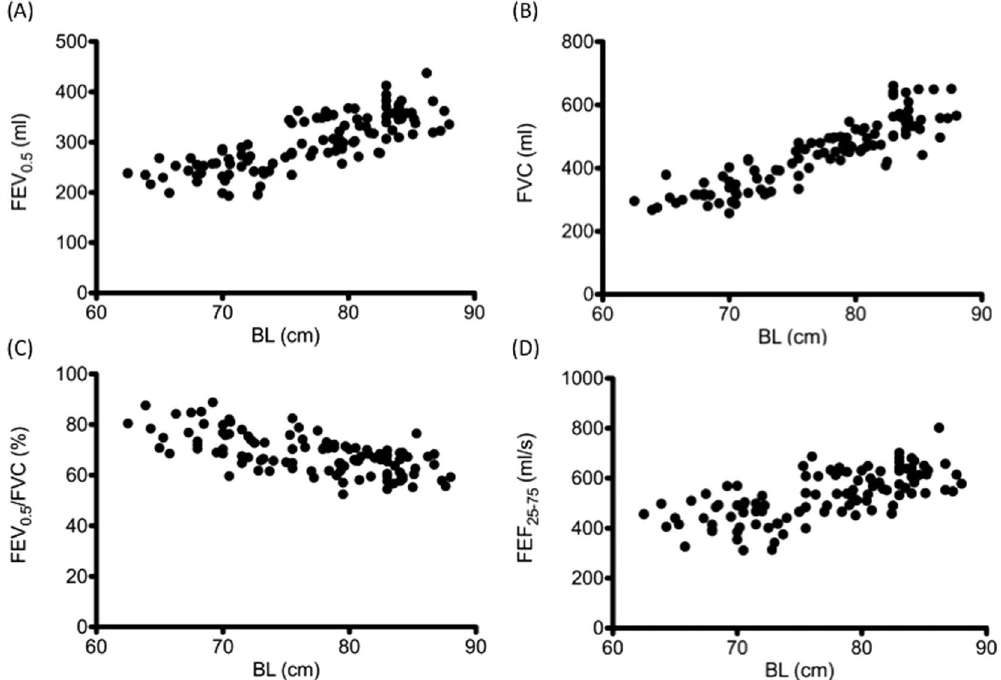
Figure 1. Scatter plots of various raised-volume rapid thoracoabdominal compression parameters. Forced expiratory volume (FEV) at 0.5 sec (FEV 0.5 ) ( A ), forced vital capacity (FVC) ( B ), FEV 0.5 /FVC ( C ), and forced midexpiratory flow (FEF 25–75 ) ( D ) plotted against body length (BL) at the time of